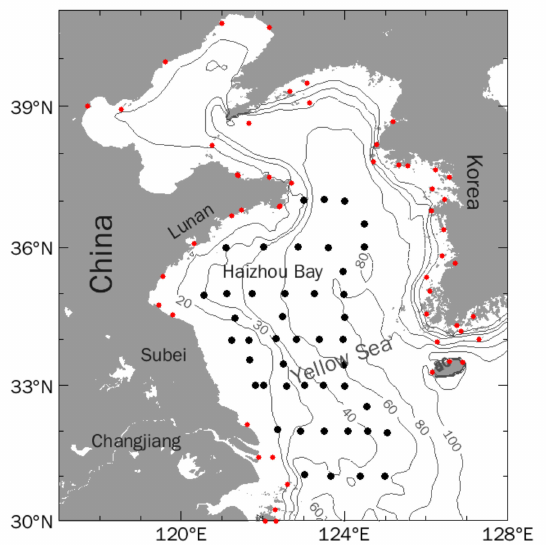
Figure 1. Bathymetry in Bohai and Yellow Seas (unit: m). Black and red dots represent cruise observation stations and tidal gauge stations,